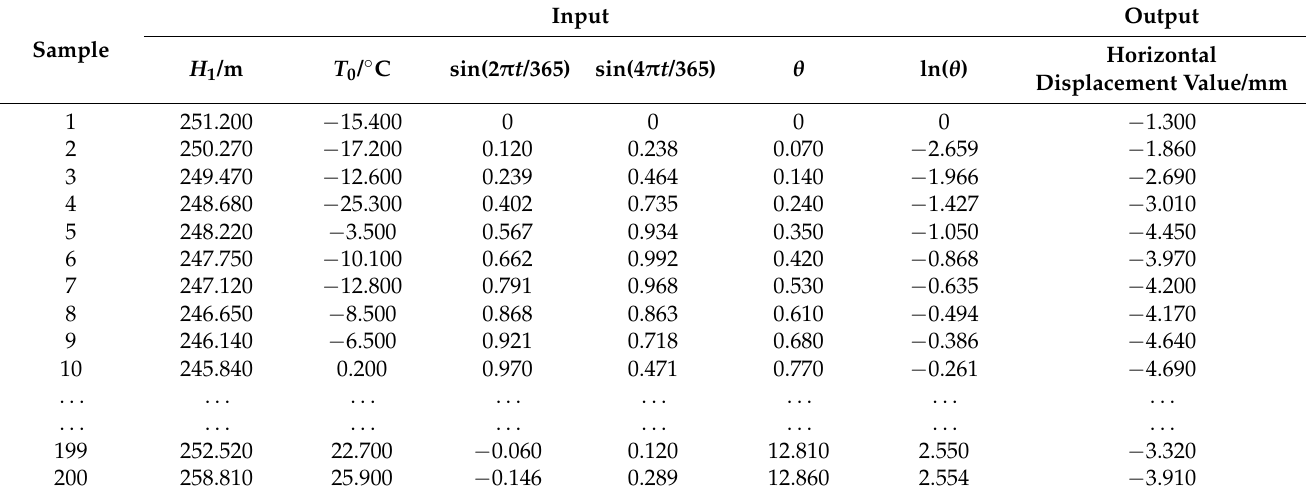
Table 2. Input and output of prediction